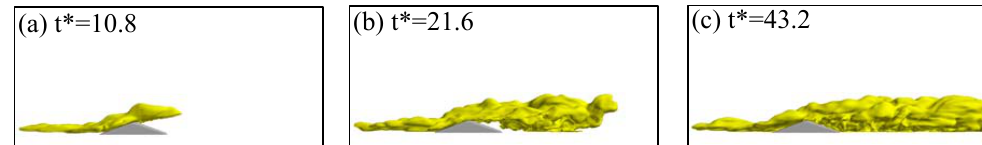
indicate 0.01% of initial concentration.